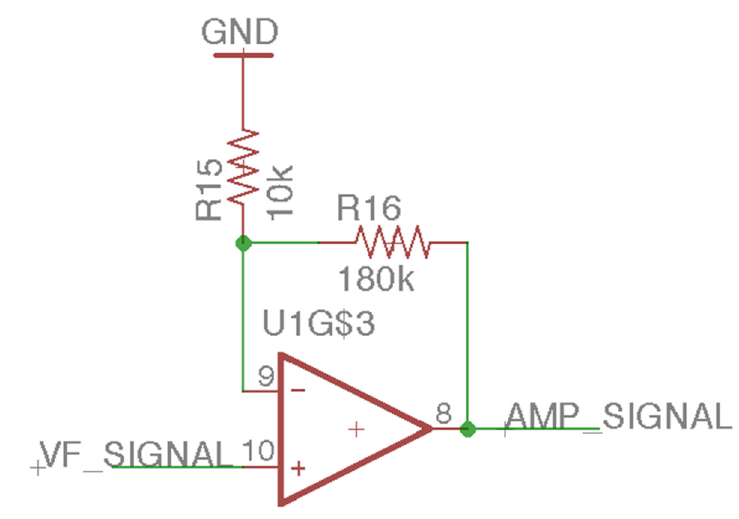
Figure 12. The feed-forward amplifier of the laser audio signal receiver circuit.